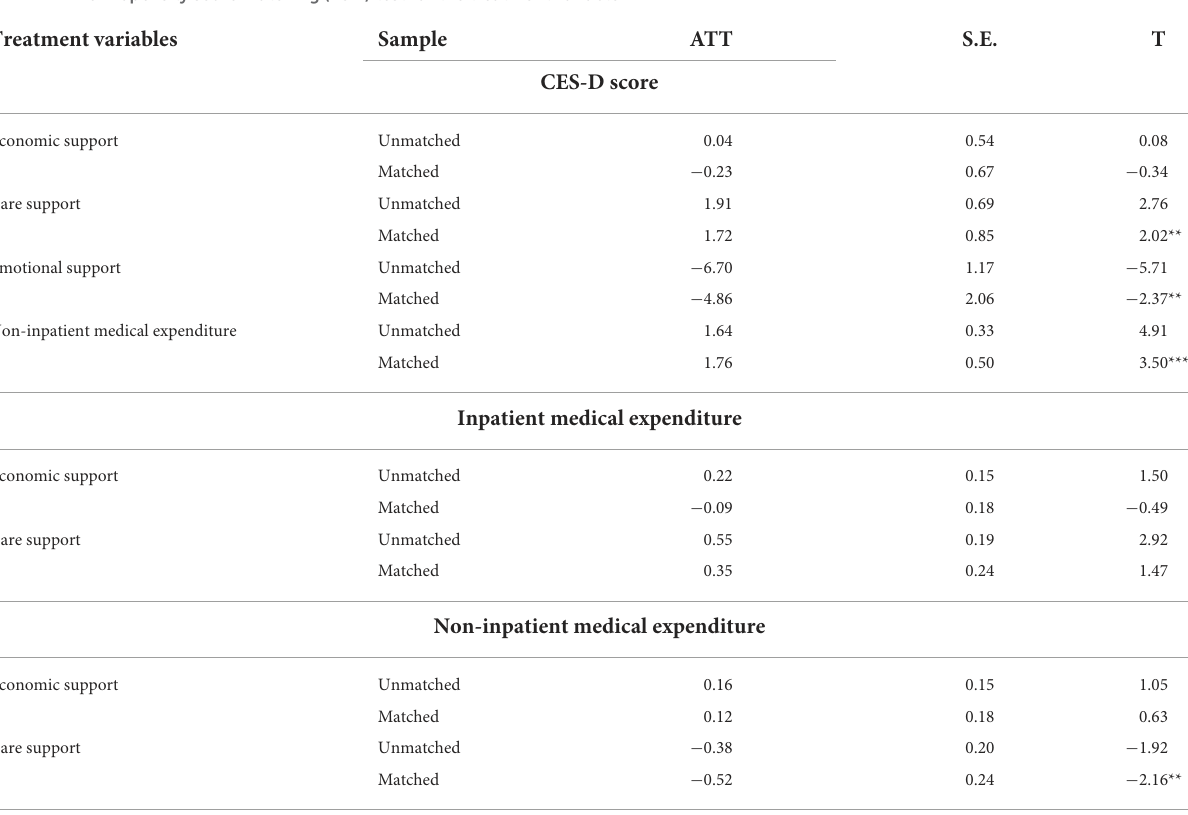
TABLE 4 The Propensity score matching (PSM) test for the treatment variable. Treatment